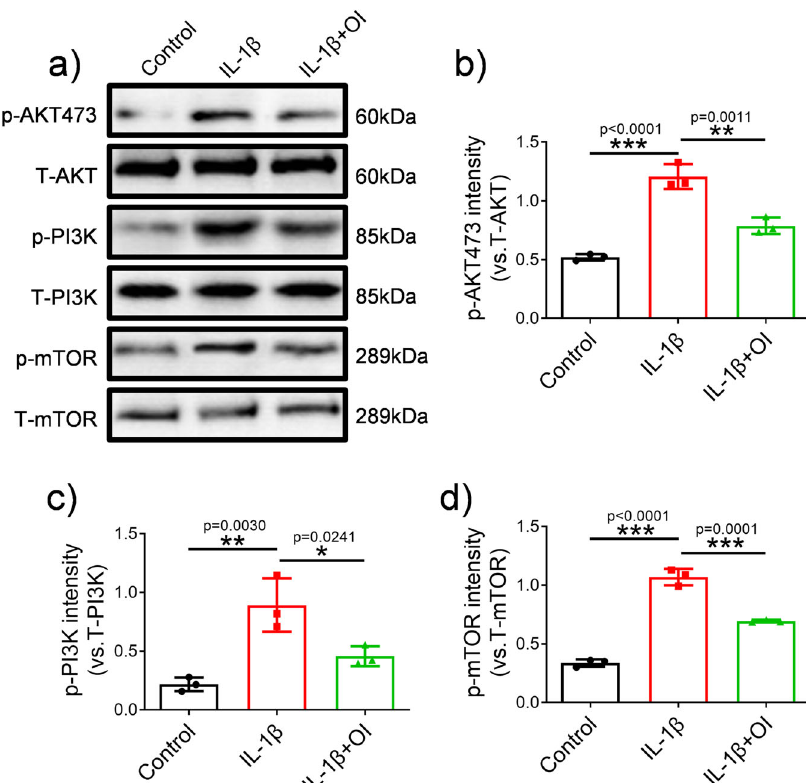
Fig. 3 OI inhibited the PI3K/AKT/mTOR signalling pathway in C28/I2 cells. a Representative images of Western blotting analysis of p-AKT, T-AKT, p- PI3K, T-PI3K, p-mTOR and T-mTOR in C28/I2 cells treated with IL-1 β and OI ( n = 3). b – d Quanti fi cation of p-AKT/T-AKT ( b ), p-PI3K/T-PI3K ( c ), and p- mTOR/T-mTOR ( d ) in the blots shown in a . The error bar is SD. The data are expressed by mean ± SD. * P < 0.05, ** P < 0.01, *** P <